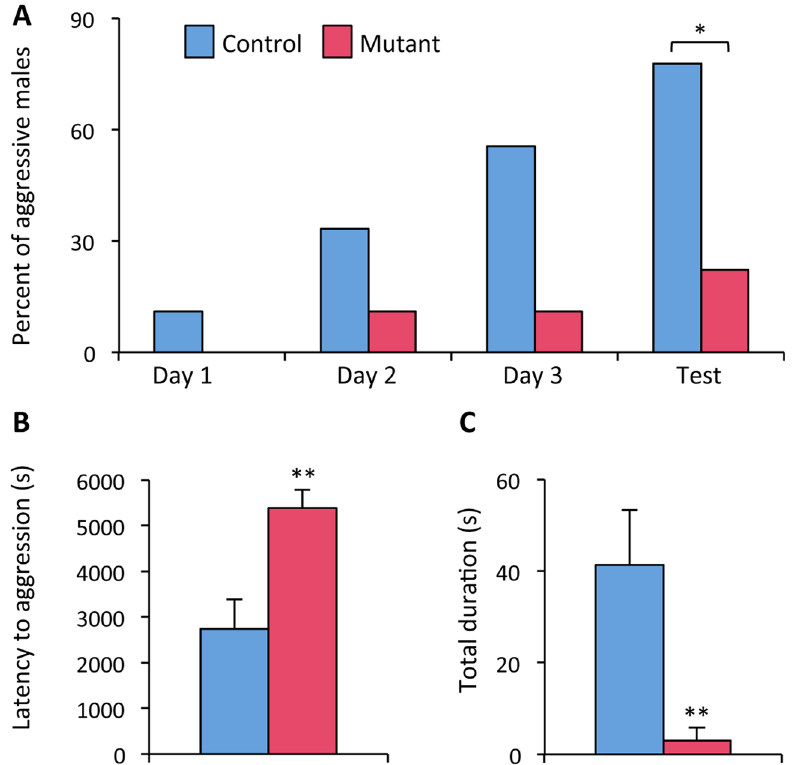
Figure 4. Aggressive behavior in control and mutant males. ( A ) Percentage of males (n = 9 males per genotype) exhibiting aggressive behavior towards intruder males over four consecutive days. * p < 0.05 versus controls. ( B ) Latency to the first attack at Test day; ** p < 0.01 versus controls. ( C ) Total duration of aggressive behavior at Test day; ** p < 0.01 versus controls.